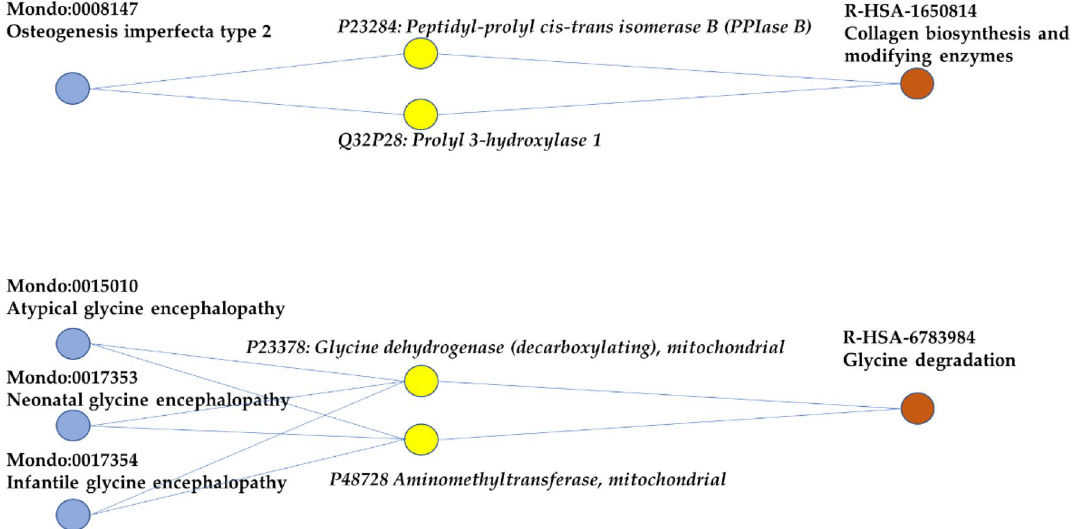
Figure 4. Examples of polygenic diseases associated with only one Reactome pathway (type A in Fig. 3). Blue, yellow and red nodes represent diseases, enzymes, and pathways,